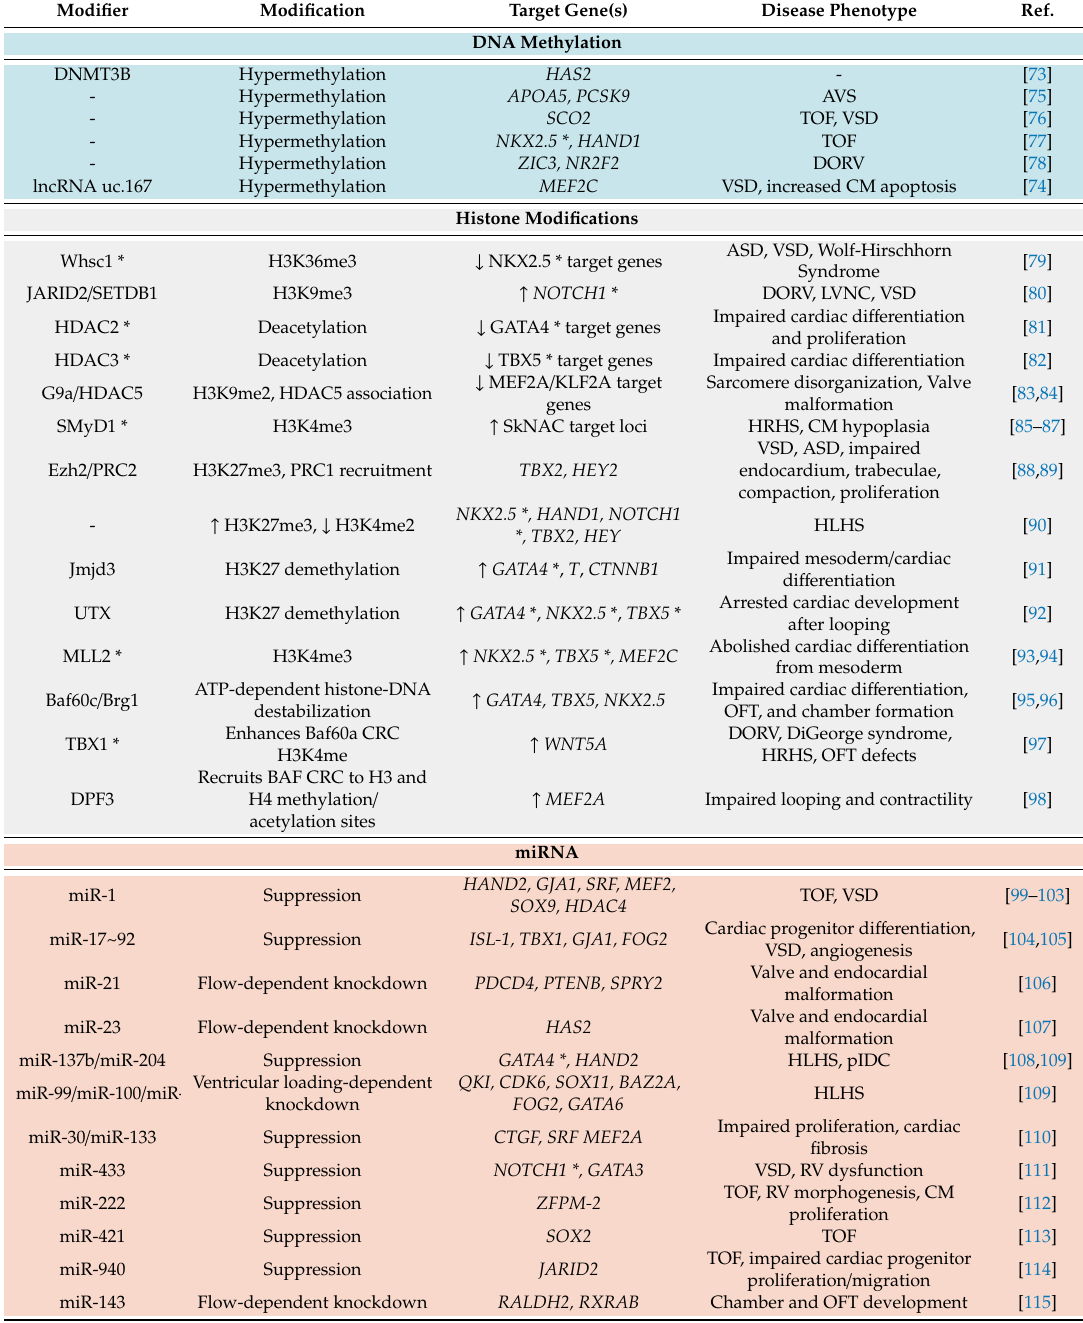
* Gene mutations identified in human cases of congenital heart disease (CHD). Abbreviations: AVS (aortic valve stenosis), TOF (tetralogy of Fallot), VSD (ventricular septal defect), ASD (atrial septal defect), DORV (double outlet right ventricle), lncRNA (long non-coding RNA), CM (cardiomyocyte), HRHS (hypoplastic right heart syndrome), HLHS (hypoplastic left heart syndrome), pIDC (pediatric idiopathic dilated cardiomyopathy), OFT (outflow tract), RV (right ventricle), ↑ (upregulation), ↓